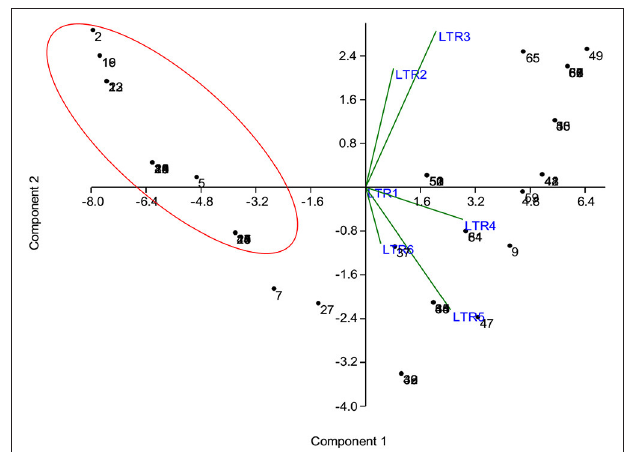
FIGURE 2 | Genotype-by-trait biplot analysis of 66 genotypes for first two principal components. LTR1-low temperature regime of 25 ◦ C for 3 days; LTR2-low temperature regime of 15 ◦ C for 7 days; LTR3-low temperature regime of 8 ◦ C for 7 days; LTR4-low temperature regime of 4 ◦ C for 7 days; LTR5-low temperature regime of 4 ◦ C for 14 days; LTR6-low temperature regime of 4 ◦ C for 21 days. The numbers in the figure represent the serial number of the genotypes enlisted in Table 1